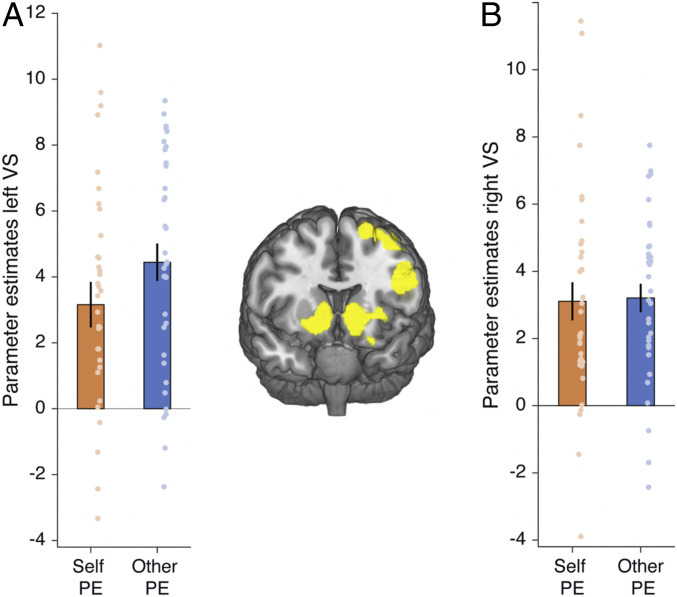
(A and B) Ventral striatum (VS) encodes prediction errors (PE) of pain avoidance for self and other. Ventral striatum (right x = 10, y = 12, z = −4, k = 236, z = 5.84; left x = −16, y = 6, z = −10, k = 458, z = 5.77, P < 0.05 FWE whole brain-corrected after initial thresholding at P < 0.001) tracked model-free prediction errors for both self and other bilaterally, with no significant differences between conditions.